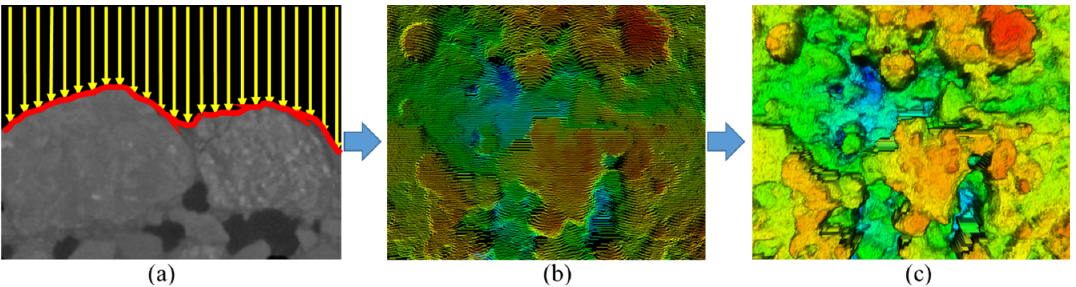
Figure 4. ( a ) One segment, ( b ) 1000 segments, and ( c ) 3D models.